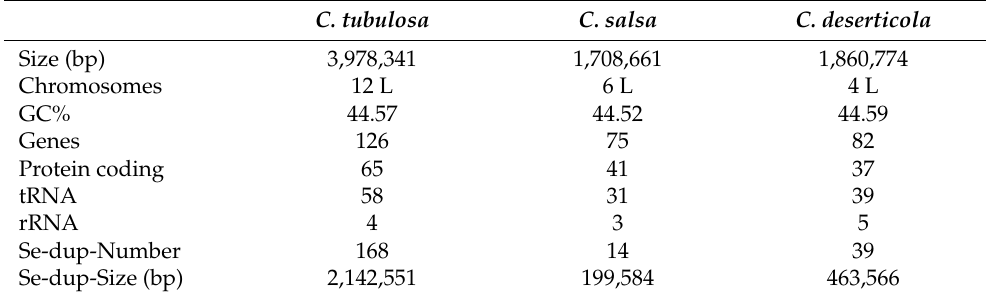
Table 1. Basic information on Cistanche species mitogenomes. In the row, Chromosomes, the number means the total number of chromosomes, while L denotes linear. Se-dup means segment duplication.